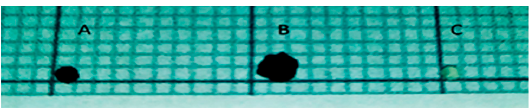
Figure 2. Photo of the beads: ( A ): CA-SCGs (3:3) beads, ( B ): CA-SCGs (3:10) beads and ( C ): CA beads. The diameters of the beads were: 1 mm ( A ); 2 mm ( B ) and 1 mm ( C ).